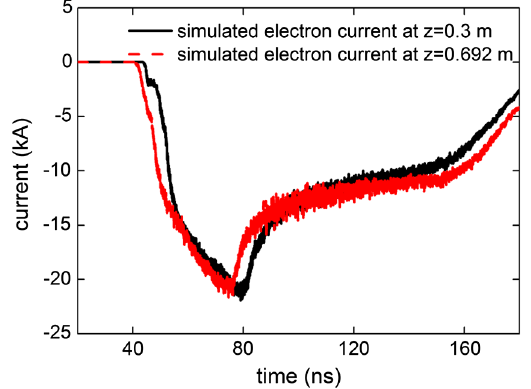
FIG. 11. Simulated anode currents at z ¼ 0 : 3 m , z ¼ 0 : 692 m , and z ¼ 1 : 22 m , corresponding to position before and after the helical support ( z ¼ 0 : 496 m ) and a position vicinity to diode. The amplitudes are 81.6, 81.1, and 81.0 kA, respectively, sug- gesting very small loss along the line.